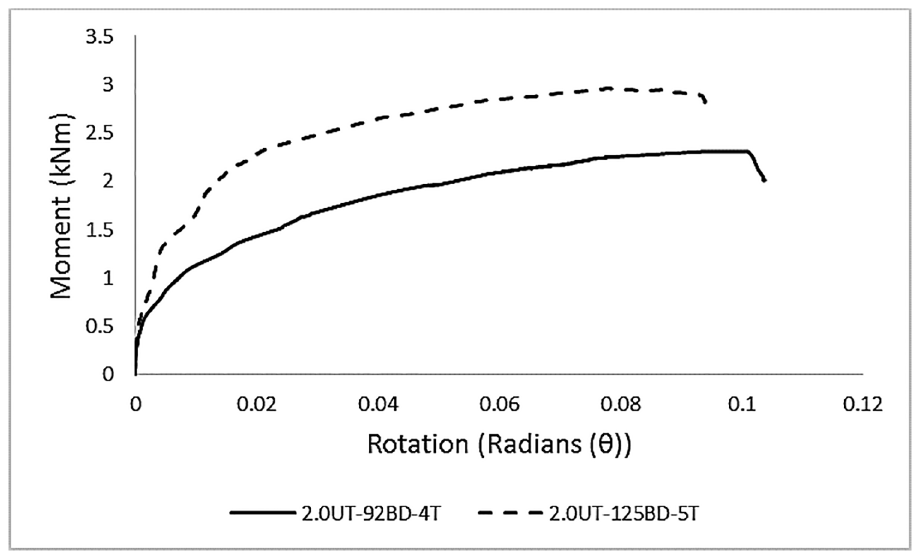
Fig 12. Effect of the geometry of the beam end